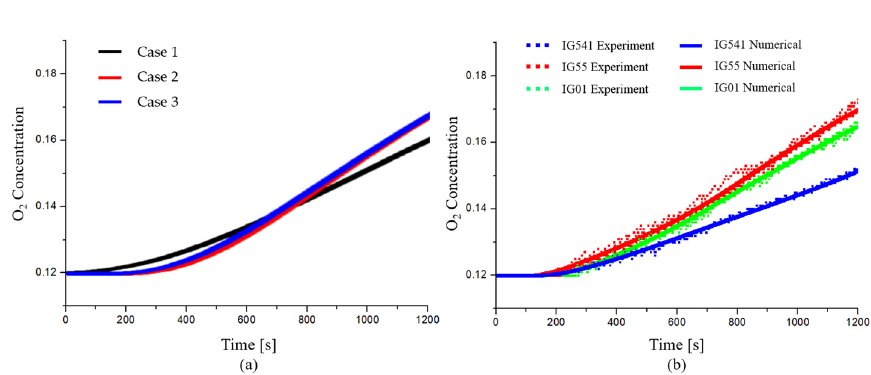
Figure 7. Mesh-sensitive study of the O 2 concentration: ( a ) Change in the O 2 concentration according to mesh sizes and elements; ( b ) comparison of the O 2 concentration between experimental and numerical results at the specified height H e . Table 4. List of initial conditions inside and outside the enclosure taken for